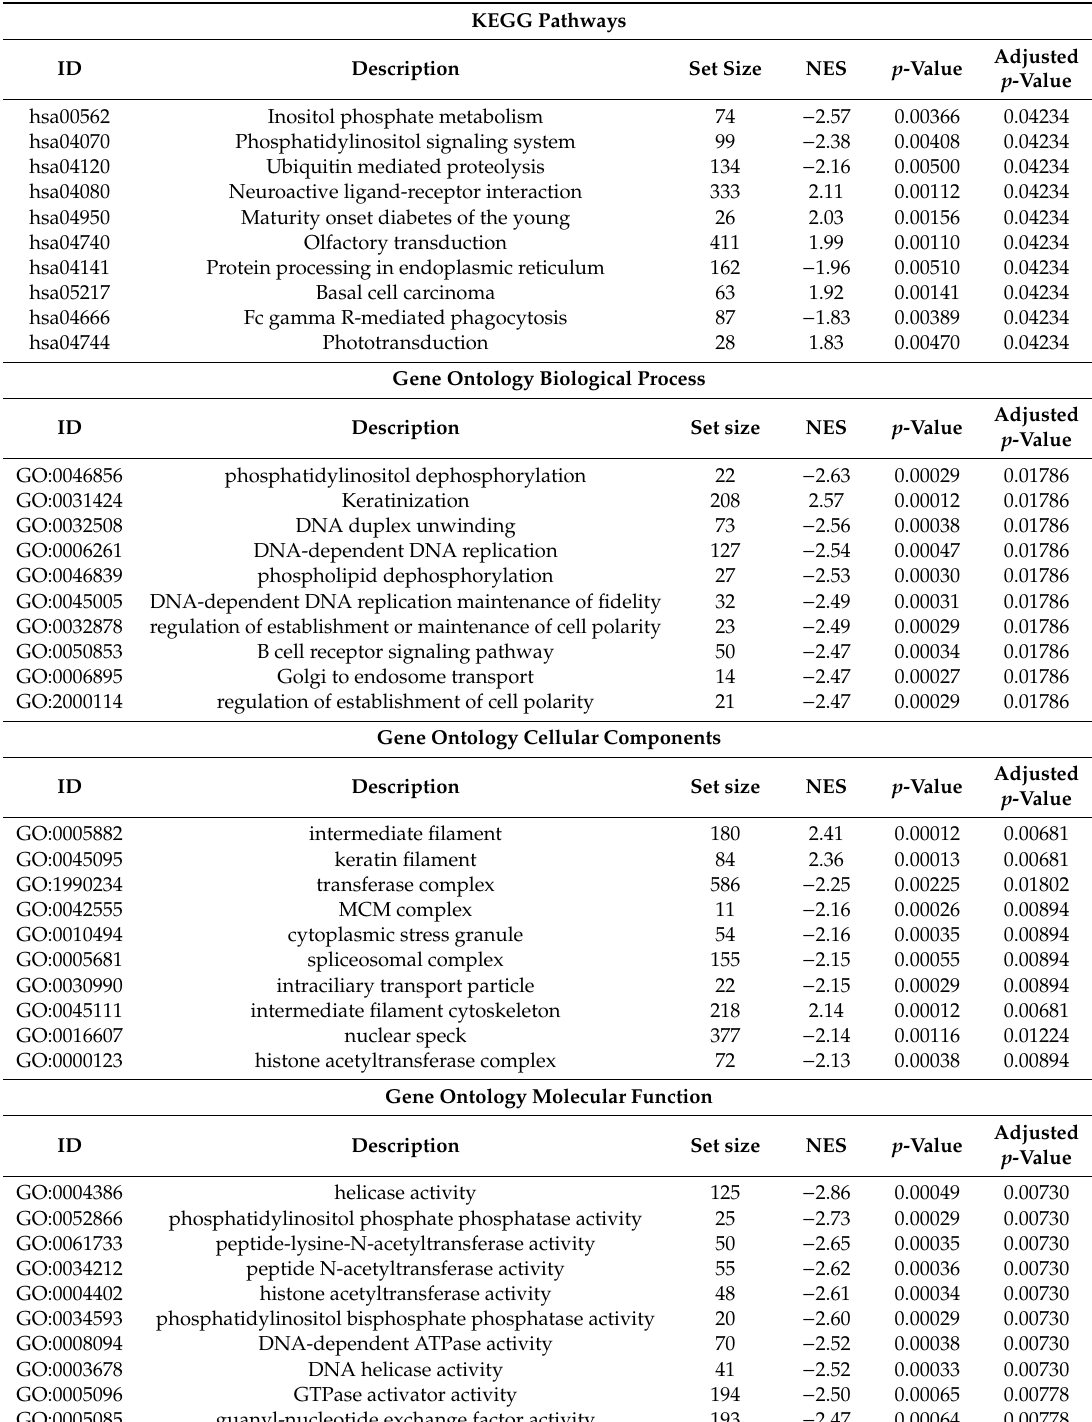
Table 5. Gene groups (pathways and gene ontology terms) significantly differentiating BRAF( + )TERTp( + ) and BRAF( + )TERTp( − ) PTCs obtained by the Gene Set Enrichment Analysis (FDR < 0.05). Ten gene groups with the highest NES were selected from each